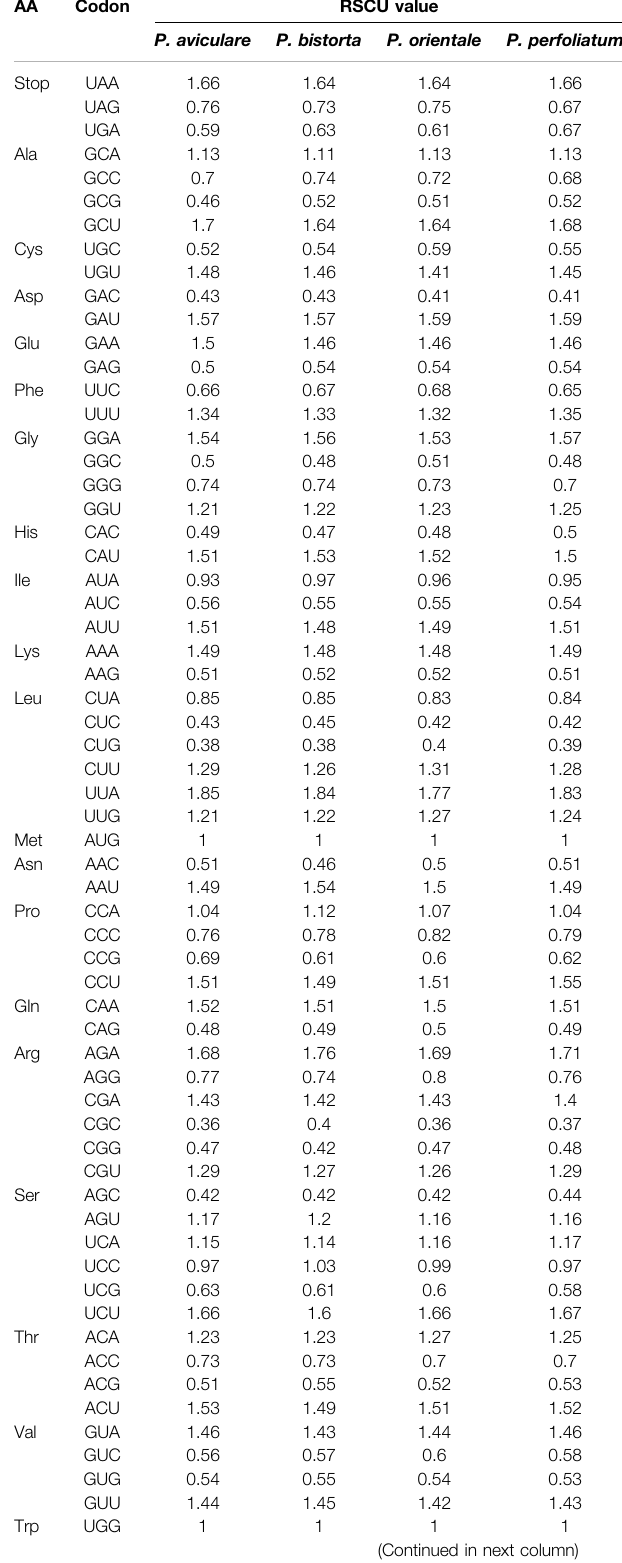
TABLE 4 | Codon – anticodon recognition patterns and codon usage of four Polygonum chloroplast genomes AA Codon RSCU